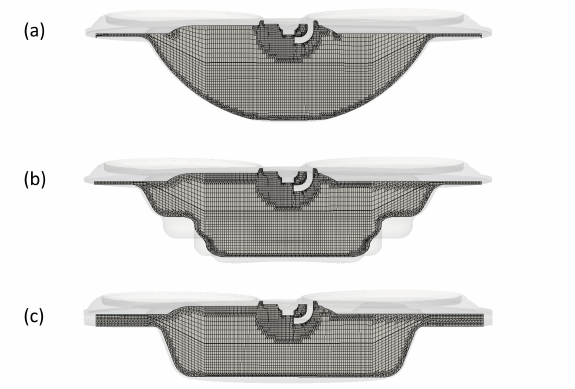
Figure 6. Computational meshes used for combustion simulations: original piston ( a ), star piston ( b ), and tower piston ( c ).